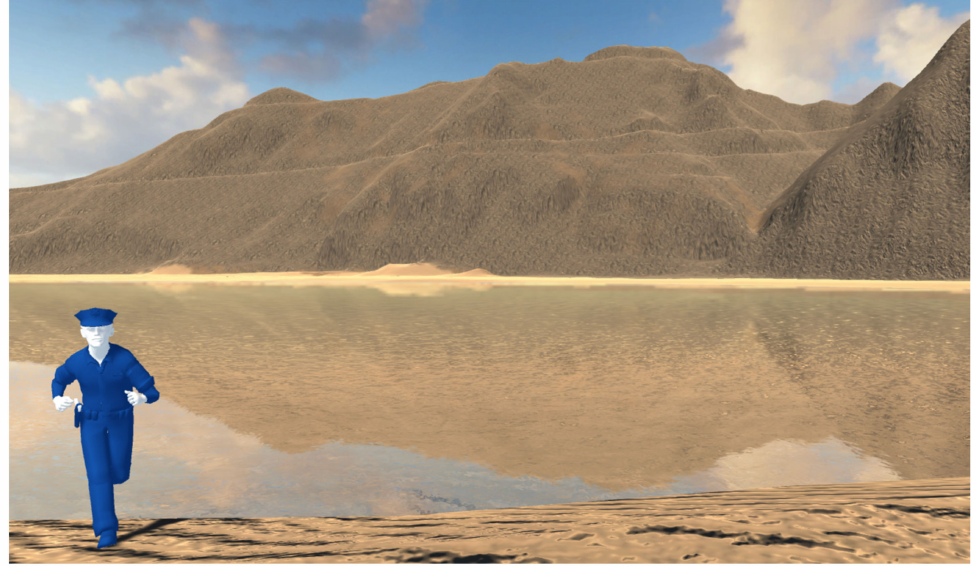
Figure 2. Las Teresitas beach landscape environment created with Unity 3D: http://playa. joseluissaorin.com accessed on 18 November 2022.